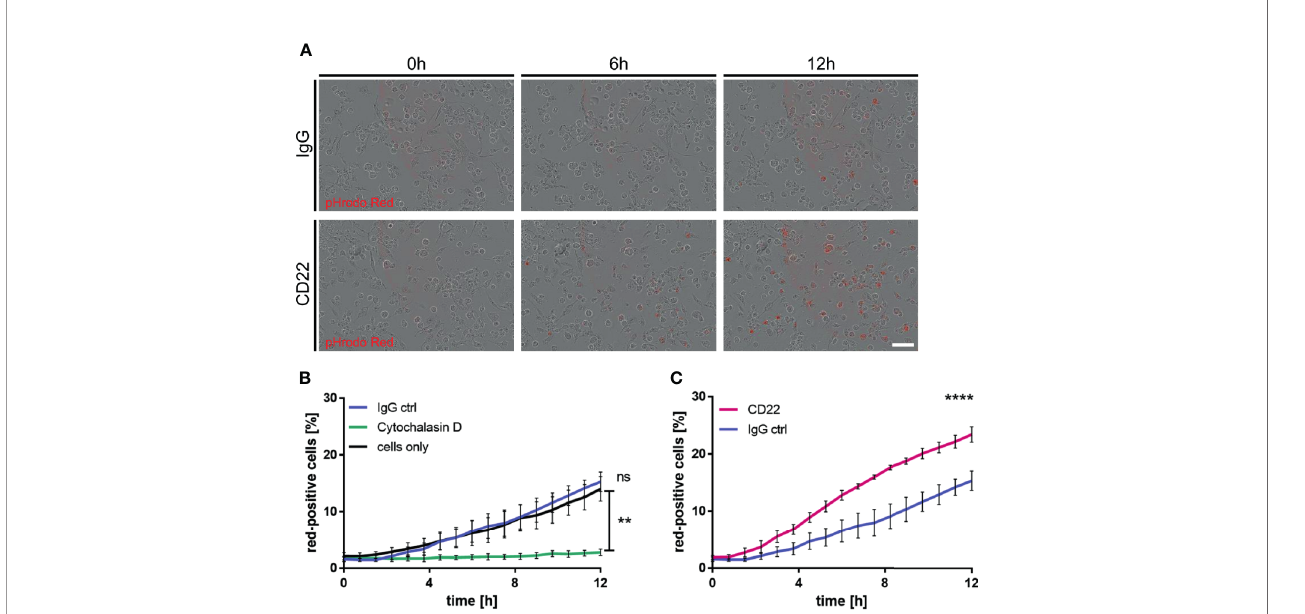
FIGURE 5 | CD22 blockage increases phagocytic capacity of human iPSC-derived macrophages. (A) Representative images of iPSC macrophages treated either with CD22 blocking antibody or IgG isotype control. Red signal indicates pH-rodo labeled A b -coated beads, which are located in the lysosomes. (B) Increase of phagocytosis-positive cells over time in untreated cells and cells treated with 5 m g/ml IgG isotype control, while no signi fi cant change is visible in cells treated with 10 m M Cytochalasin D. Cells were monitored using IncuCyte S3 and analyzed using IncuCyte cell by cell analysis. (C) Raise in phagocytosis positive cells over time in cells treated with 5 m g/ml CD22 blocking antibody or 5 m g/ml IgG isotype control. Cells were monitored using IncuCyte S3 and analyzed using IncuCyte cell by cell analysis. n=3, mean ± SEM, unpaired nonparametric t-test (Mann-Whitney), **p<0.01, ****p<0.0001.